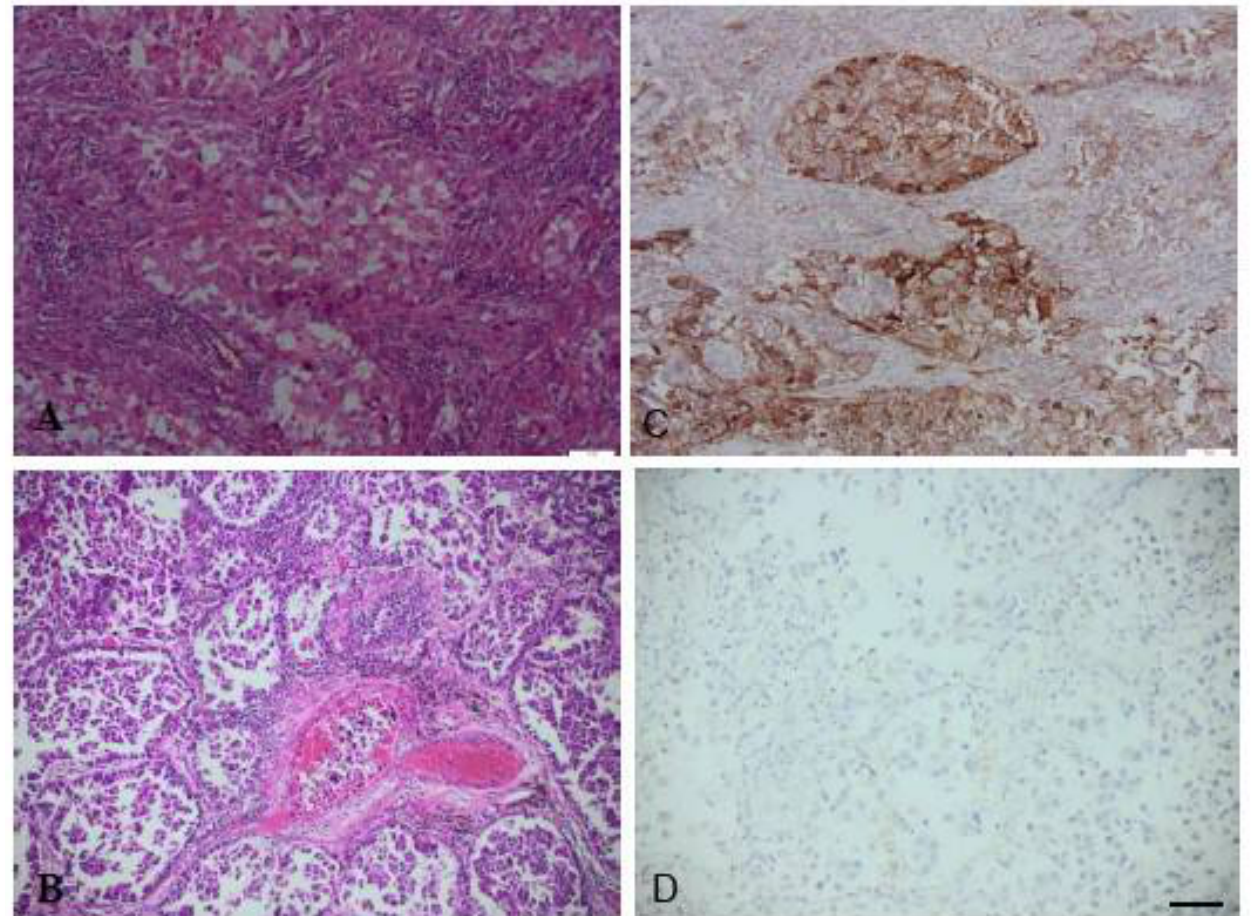
Figure 4. In ADC ( A —hematoxylin and eosin staining), positive PD-L1 expression is more common in solid subtype—brown staining ( C ) while in the papillary subtype ( B —hematoxylin and eosin staining), PD-L1 expression in the papillary subtype is negative ( D ). Scale bar 25 µm.